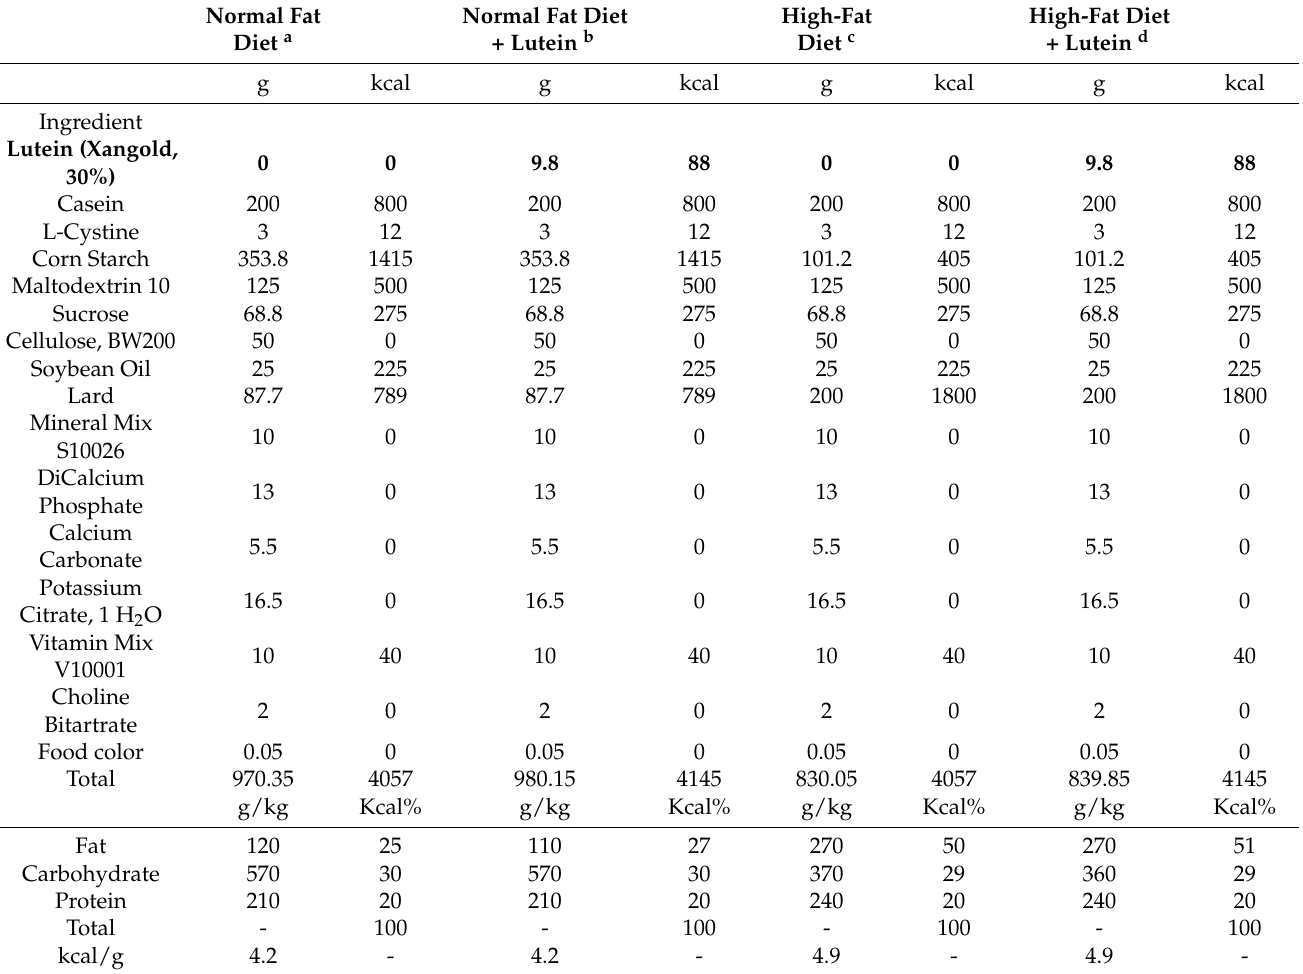
Table 1. Diet composition of normal- and high-fat purified diets with or without